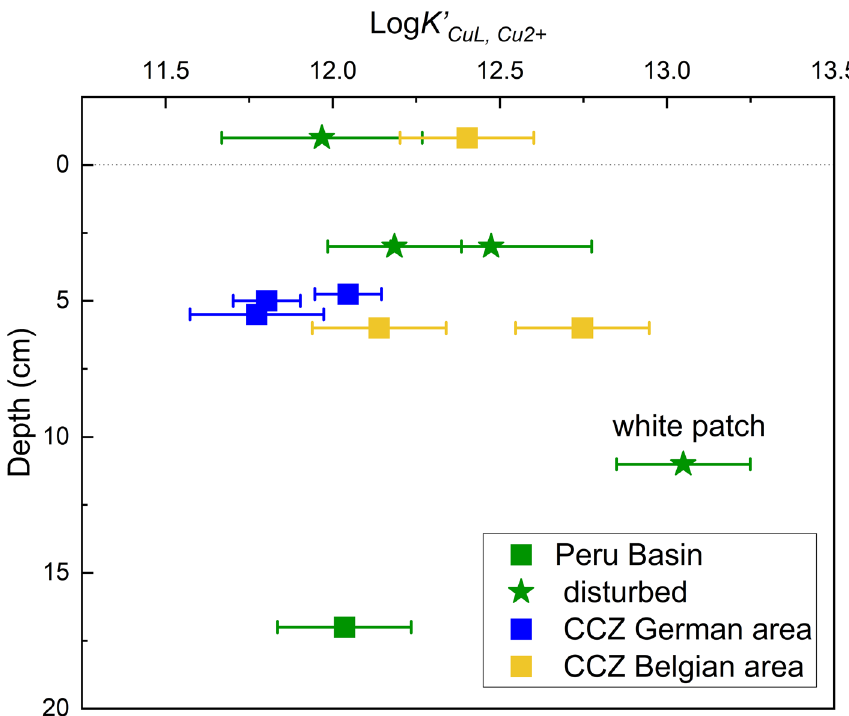
Figure 6. Log K’ CuL, Cu2 + values vs. depth for all samples that could be fitted with ProMCC: 5/10 Peru Basin, 3/18 CCZ German area, 3/9 CCZ Belgian area. For details see Table 2. Samples from each study site are grouped. The uppermost (-1 cm) value shows the bottom